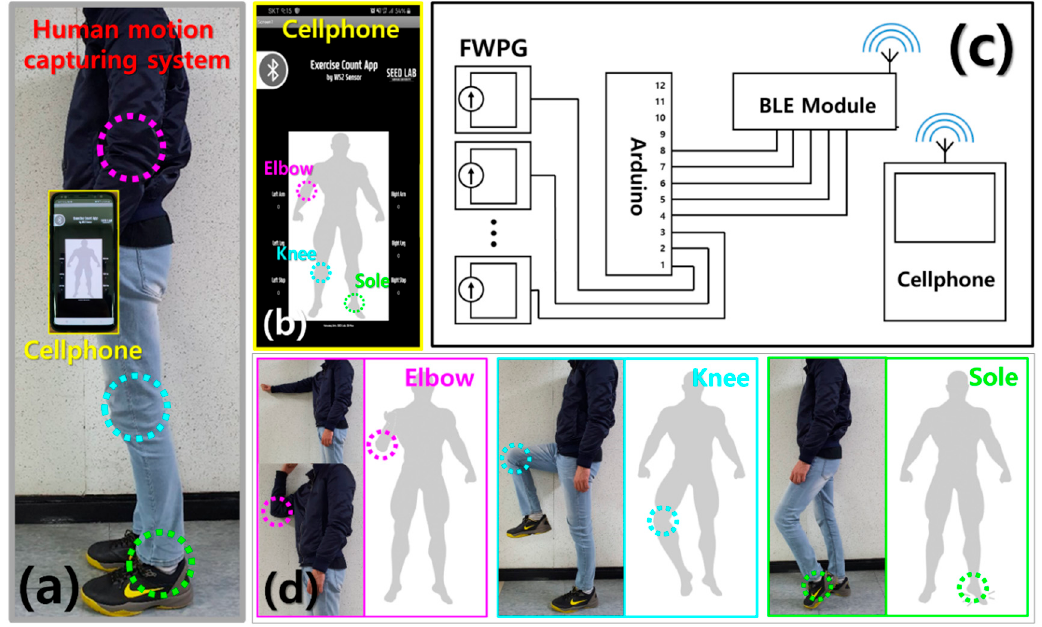
Figure 11. ( a ) The gesture capturing system based on the smart cloth. ( b ) Photograph of cellphone app system from